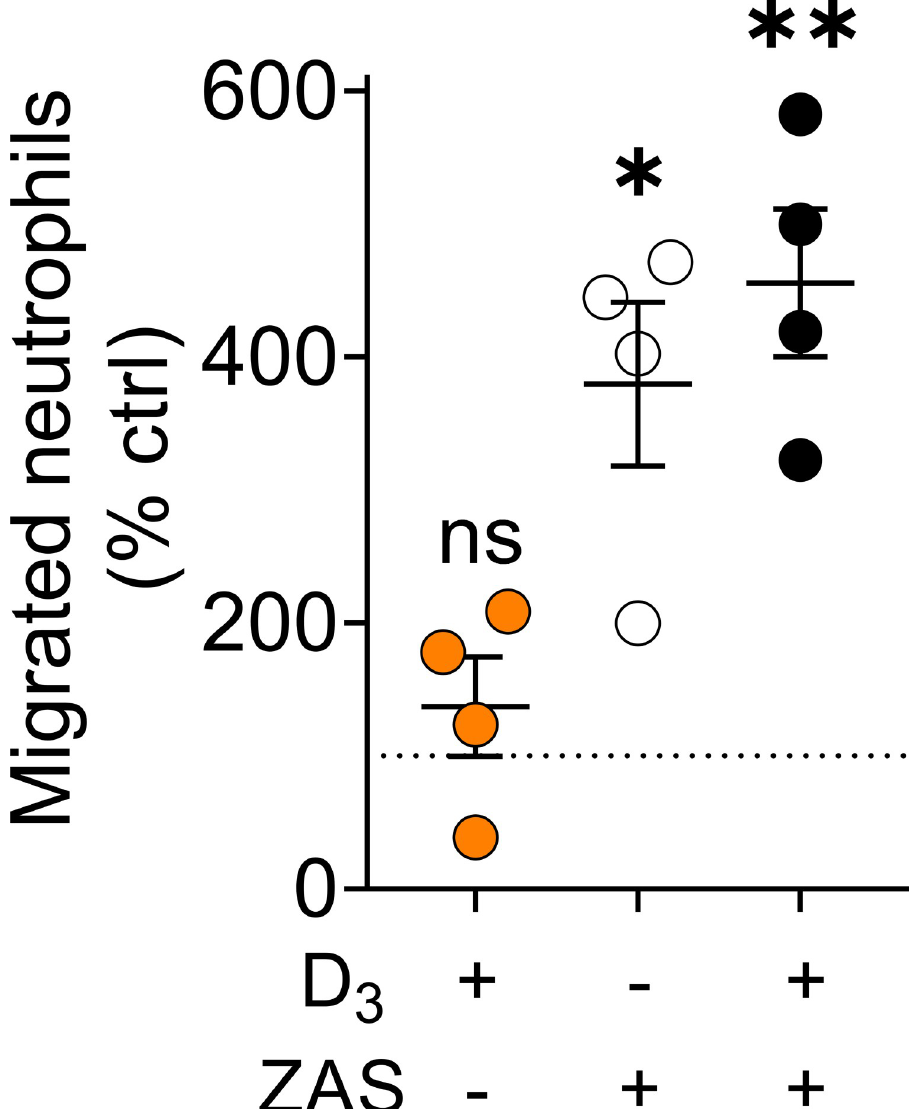
Fig 3. Effect of overnight calcitriol treatment on neutrophil migration across hAECs. Percent of migrated neutrophils across hAECs with (orange and black circles) and without (white circles) overnight calcitriol treatment, n = 4 hAEC donors, each dot represents the average of triplicate data per experiment, neutrophils isolated from one healthy donor. Neutrophil migration was performed under USG and 30% zymosan activated serum (ZAS) conditions; significance determined by comparing baseline-corrected data of each condition to untreated hAECs using a one- sample t-test with hypothetical mean of 100, � indicates p < 0.05, �� indicates p < 0.01, error bars indicate mean ±